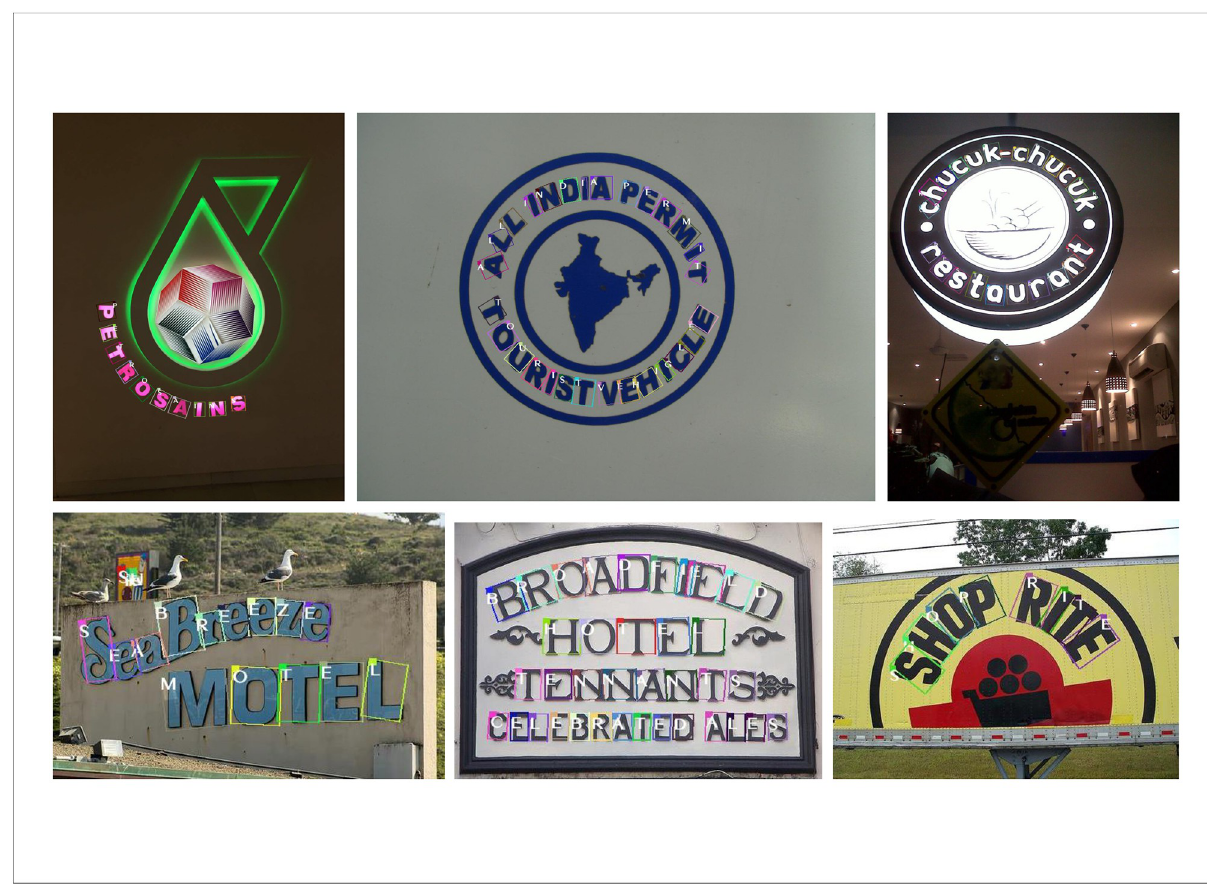
Fig 9. Qualitative results of MA-CharNet on irregular datasets. For better visualization, we do not show the given text outer border. Unlike other text recognition networks, MA-CharNet can recognize multiple texts in a single image at the same time. Reprinted from [19] under a CC BY license, with permission from IJDAR, original copyright